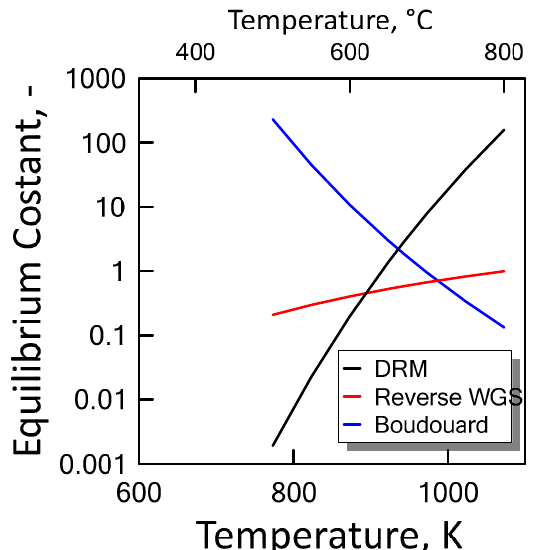
Figure 6. Equilibrium constant as a function of temperature for DRM ( ▬ ), reverse WGS ( ▬ ) and Boudouard ( ▬ ) reactions.